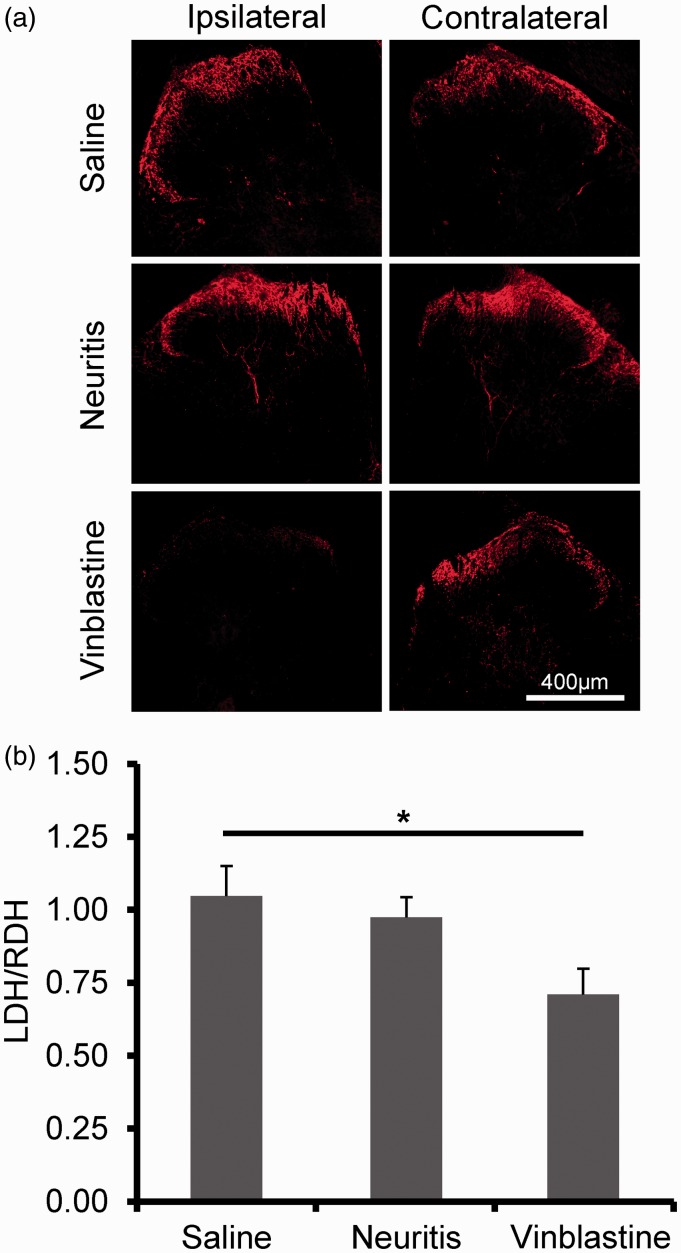
Substance P expression in the dorsal horn. (a) Typical example images of substance P expression in the L5 region of the dorsal horn in saline-treated, neuritis and vinblastine-treated groups. The majority of expression is observed within the superficial lamina (red staining). (b) Mean ratios of the dorsal horn area expressing substance P. Calculation was made by dividing the ipsilateral area by the contralateral area. n = 3 animals in each group. *p < 0.05 (one-way ANOVA followed by Bonferroni’s post hoc test). Error bars = SEM.ANOVA: analysis of variance; LDH: Left dorsal horn; RDH: Right dorsal horn; SEM: standard error of the mean.